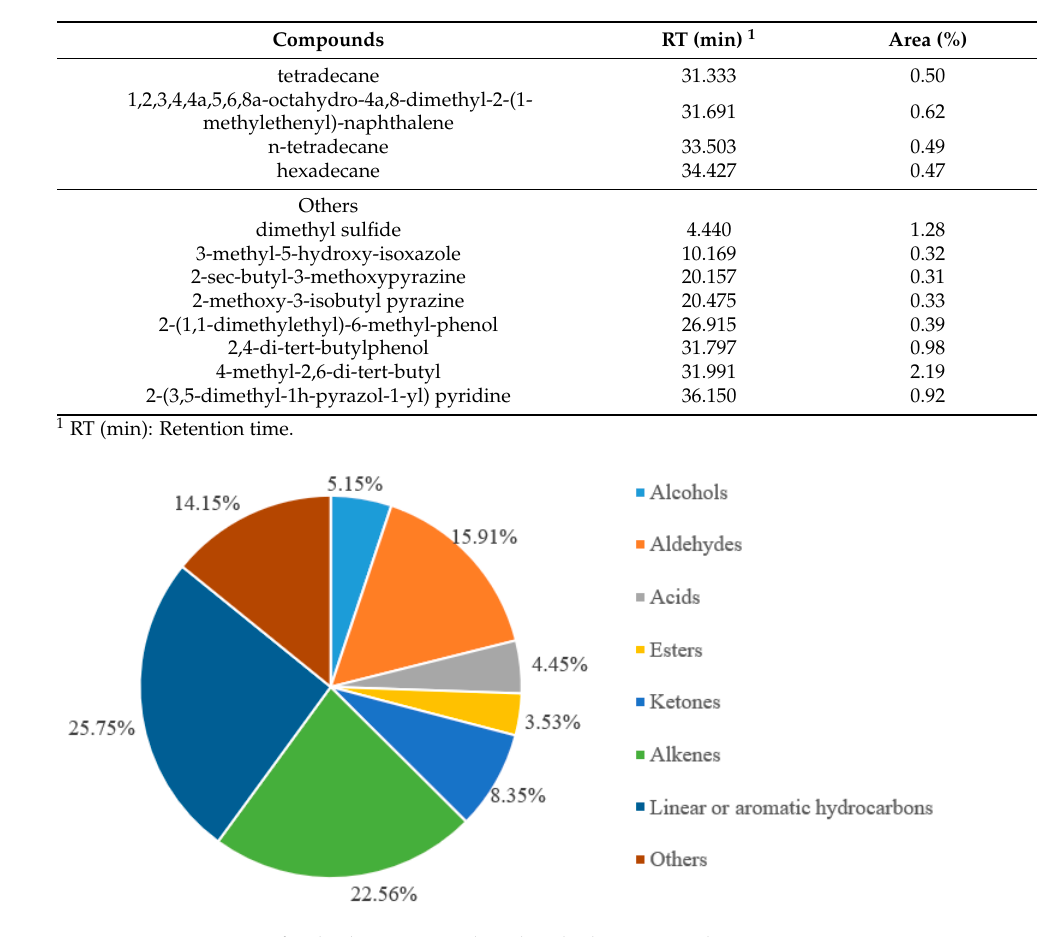
Figure 3. Proportion of volatile compounds in burdock root powder.